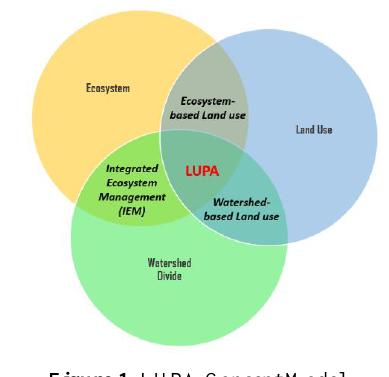
Figure 1. LUPA Concept